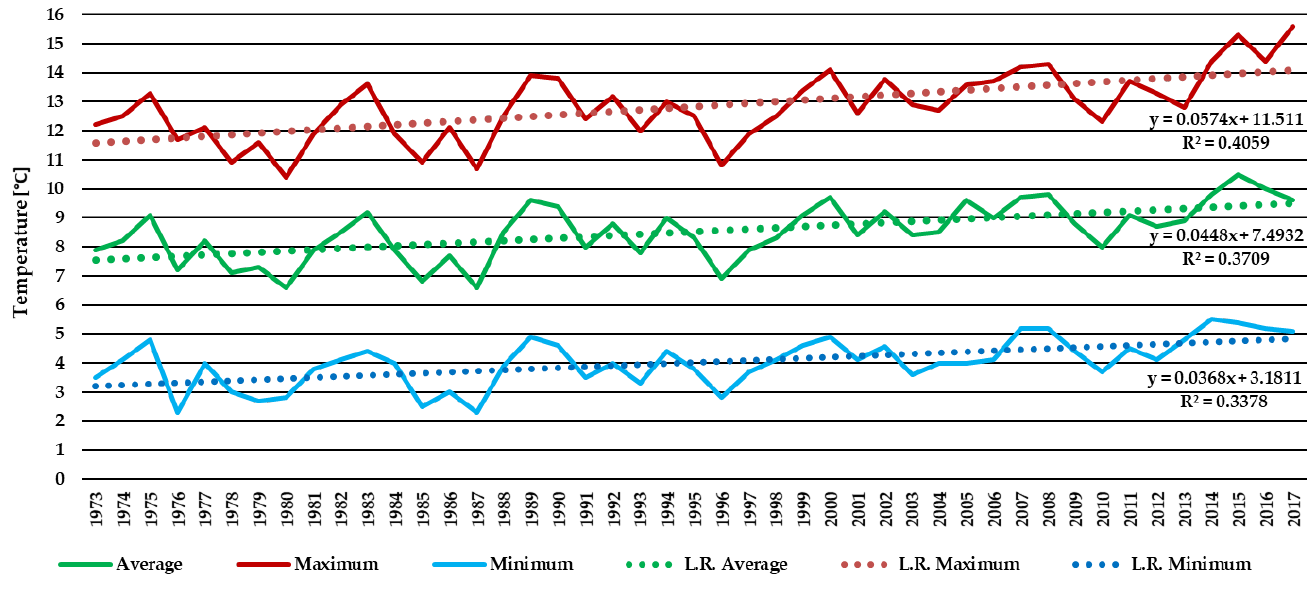
Figure 1. The mean monthly temperatures (°C) (average, minimal, and maximal) in the years 1970 – 2016 measured at the Warsaw- Okęcie meteorological station (10 km in a straight line from PAS Botanical Garden) and the linear trend lines in this period.